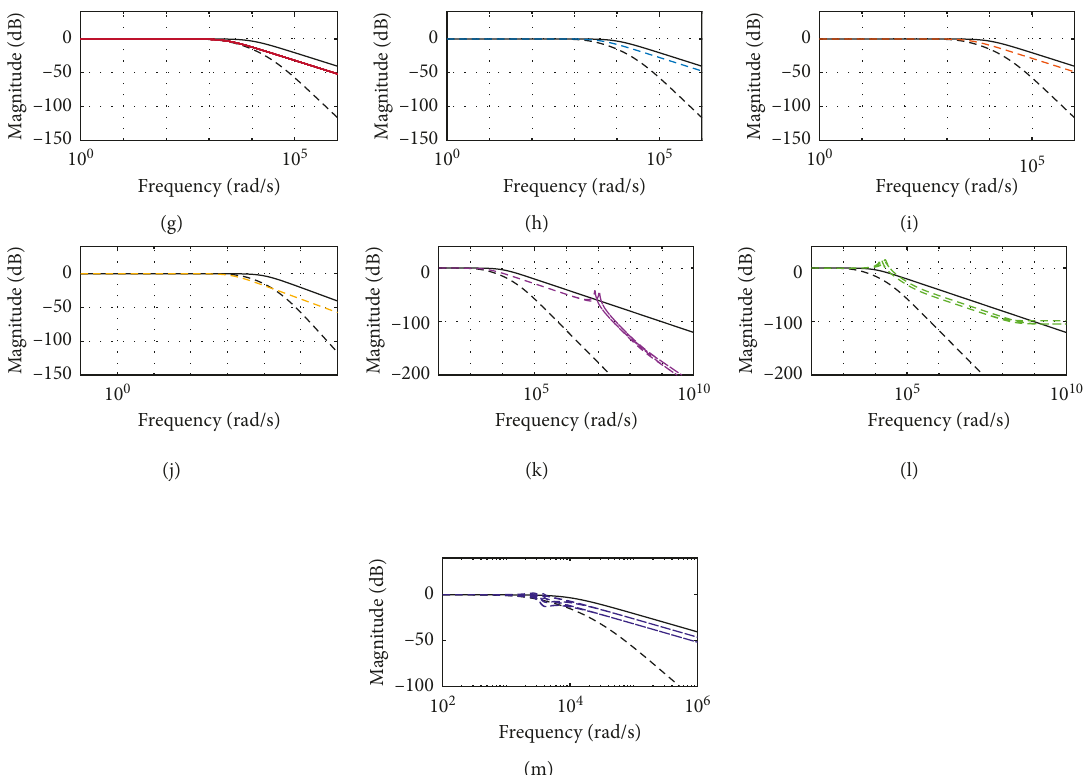
Figure 6: Compared frequency-domain worst case response of the closed-loop system: (a) BA; (b) FPA; (c) ABC; (d) BBO; (e) HS; (f) DE; (g) ICA; (h) IWO; (i) TBLO; (j) ACO; (k) Ibarra et al.; (l) Zeigler Nichols; (m) IMC.